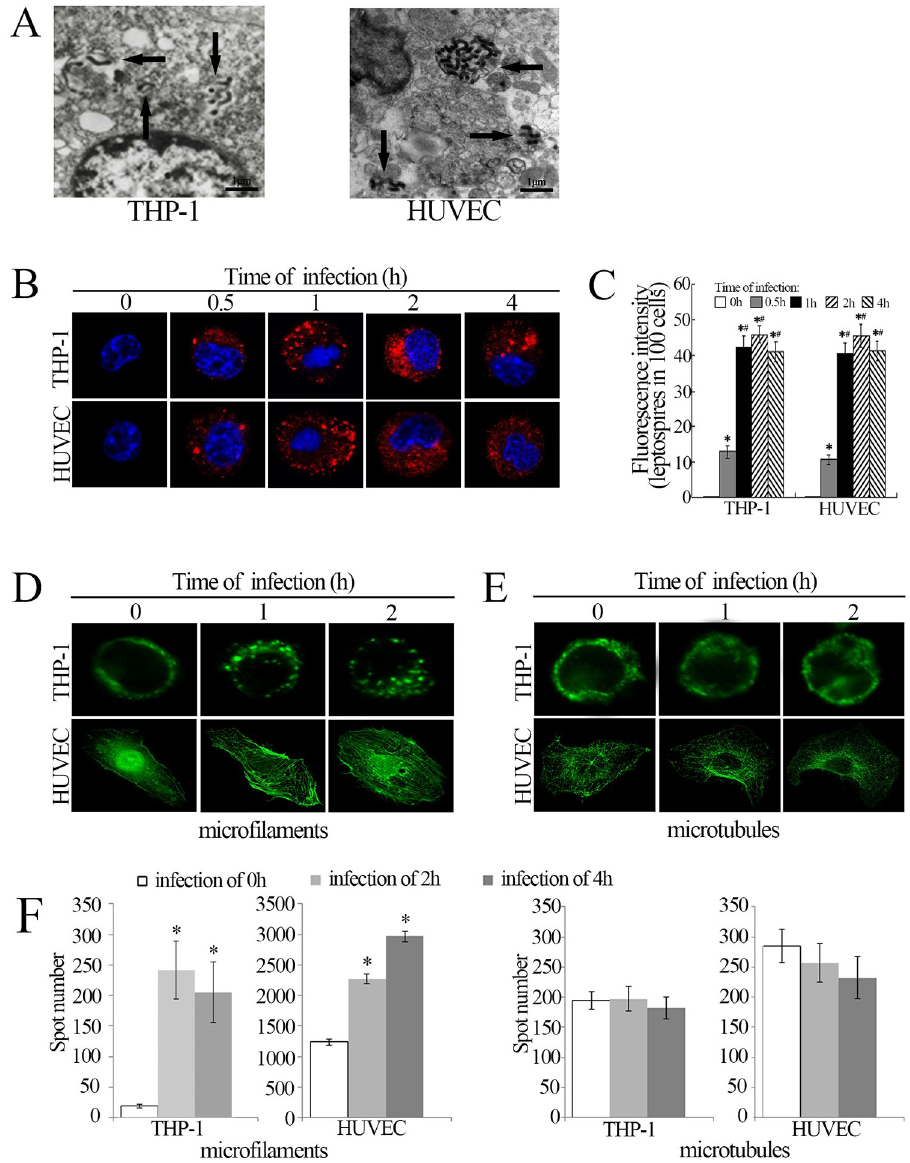
Fig 1. Internalization of Leptospira in THP-1 and HUVEC. A: Leptospires in THP-1 and HUVEC under the transmission electron microscope after infection with L . interrogans strain Lai for 1 h. The arrows indicate the intracellular leptospires; B: Leptospires in THP-1 and HUVEC under the laser confocal microscope after infection with L . interrogans strain Lai for the indicated times. The blue plaques in the middle of cells indicate the nuclus. The red spots around the nuclus indicate the intracellular leptospires; C: Statistical summary of red fluorescence intensity reflecting the leptospires in THP-1 and HUVEC after infection with L . interrogans strain Lai for the indicated times. Statistical data from experiments such as shown in B. Bars show the means ± SD of three independent experiments. The 0 h indicates the cells before infection. One hundred cells were analyzed for each of the specimens. � : p < 0.05 vs the red fluorescence intensity in the three cells before infection. # : p < 0.05 vs the red fluorescence intensity reflecting the leptospires in the cells after infection with the spirochete for 0.5 h; D: Microfilament aggregation in THP-1 and HUVEC during infection with L . interrogans strain Lai for the indicated times; E: No microtubule aggregation in THP- 1 and HUVEC during infection with L . interrogans strain Lai for the indicated times. F: Spot number of polymerized actin and tubulin. Bars show the means ± SD of three independent experiments. � : p < 0.05 vs the spot number of actin or tubulin which cells infected of